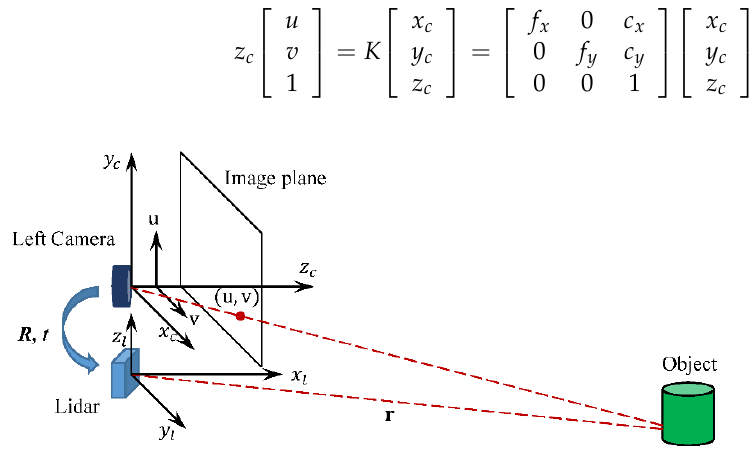
Figure 7. The left camera coordinate and LiDAR